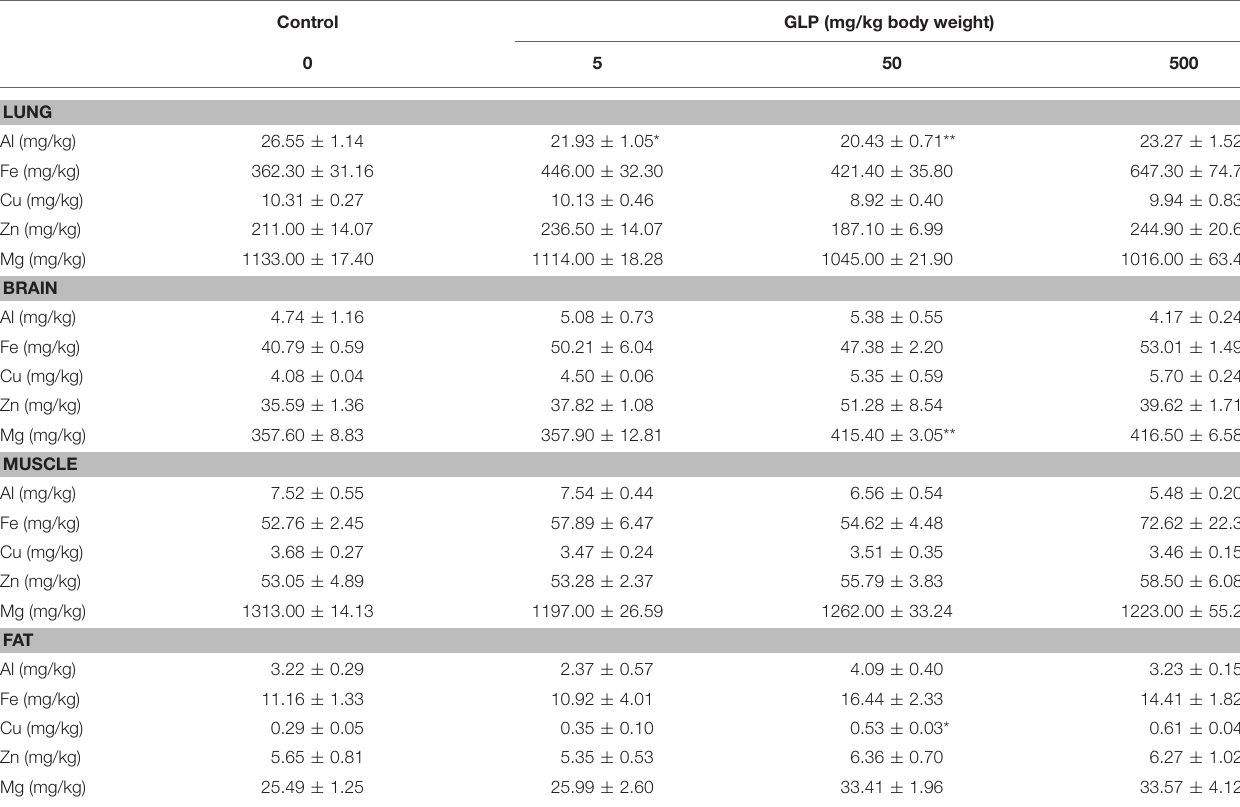
TABLE 5 | The concentrations of Al, Fe, Cu, Zn, and Mg in the lung, brain, muscle and fat of rats.